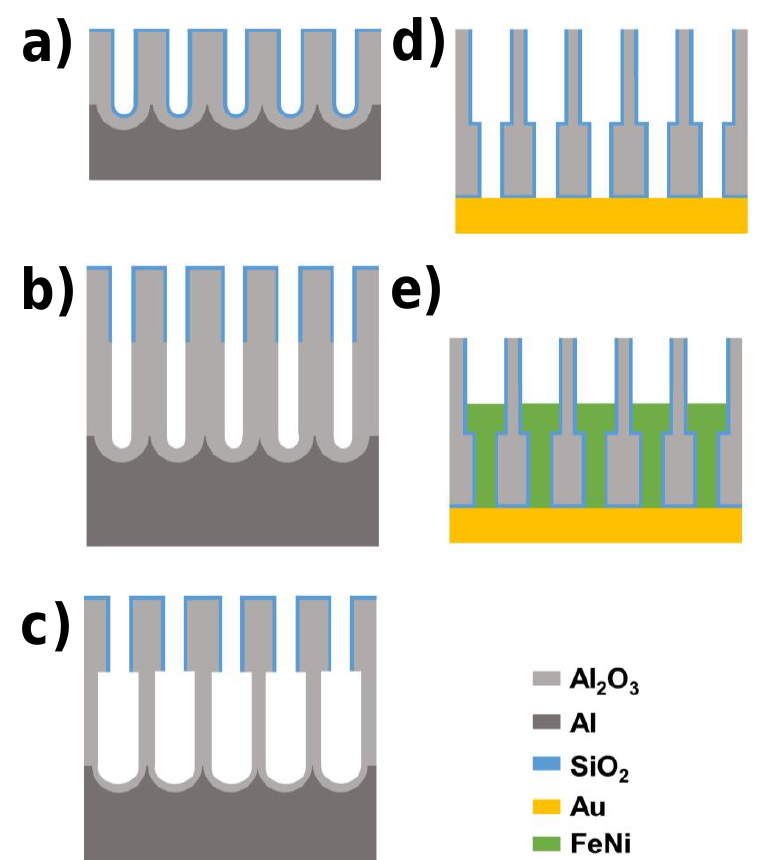
Figure 1. Fabrication flowchart of diameter-modulated FeNi alloy nanowire arrays by template-assisted deposition in tailored geometrically modulated nanoporous alumina membranes. ( a ) Second anodization and SiO 2 deposition. ( b ) Third anodization. ( c ) Pore widening. ( d ) Al substrate and barrier layer removal, ALD coating and gold contact deposition. ( e ) Electrodeposition growth of bi-segmented NiFe alloy nanowires.